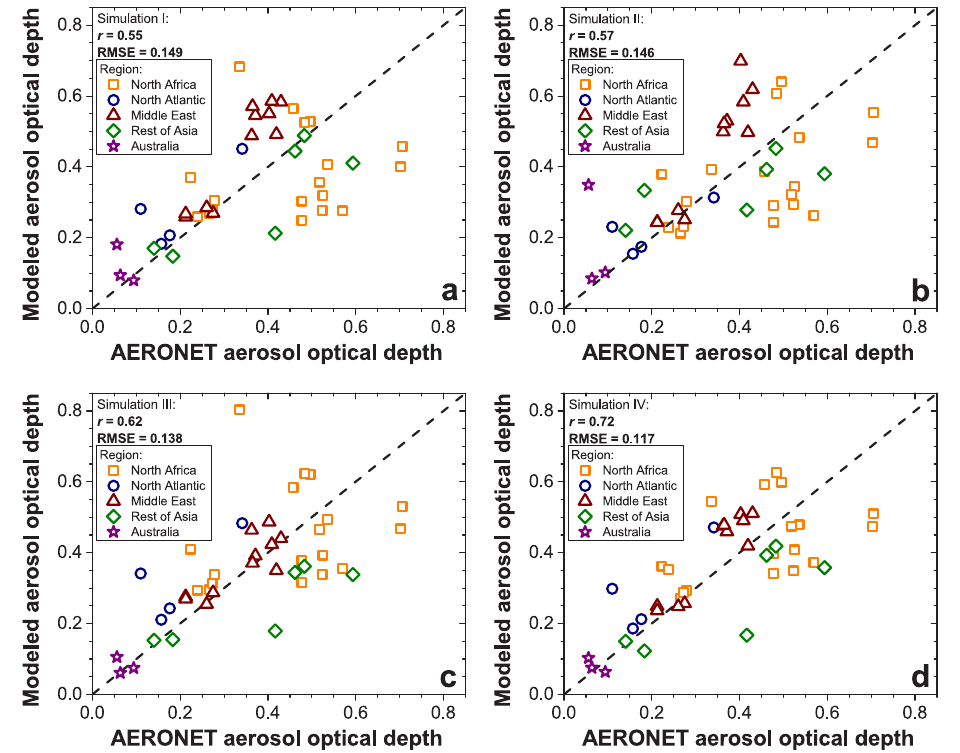
Figure 5. Comparison of measured and modeled AOD at 42 dust-dominated AERONET stations. Results are shown for (a) simulation I (no source function), (b) simulation II (Zender et al. (2003b) geomorphic source function), (c) simulation III (Ginoux et al. (2001) source function), and (d) simulation IV (no source function, and dust flux is parameterized following K14 instead of Z03). For each simulation, the RMSE and r are noted.